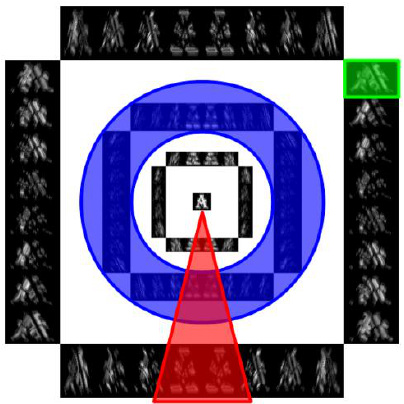
Figure 2. Curvelet coefficients intensity of test image—blue ring equates one scale, red triangle equates one direction, green rectangle equates the locations of one scale and one